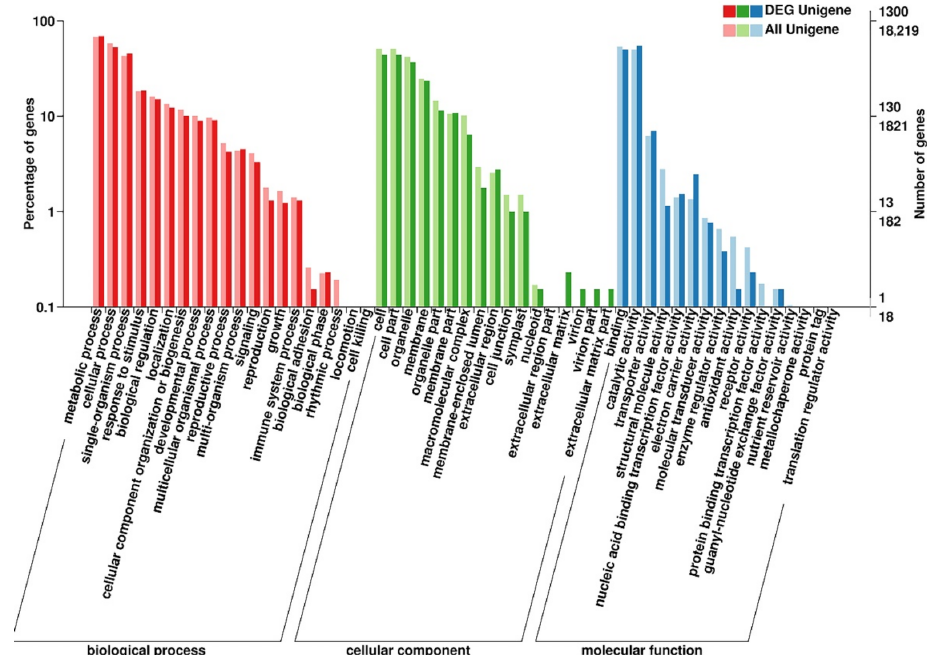
Figure 5. GO annotation of DEGs identified in the comparison between H3 and B3. The horizontal axis is the GO classification, the left side of the vertical axis is the percentage of the number of genes, and the right side is the number of genes. Red columns represented biological processes, green columns represented cellular components, and blue columns represented molecular functions.